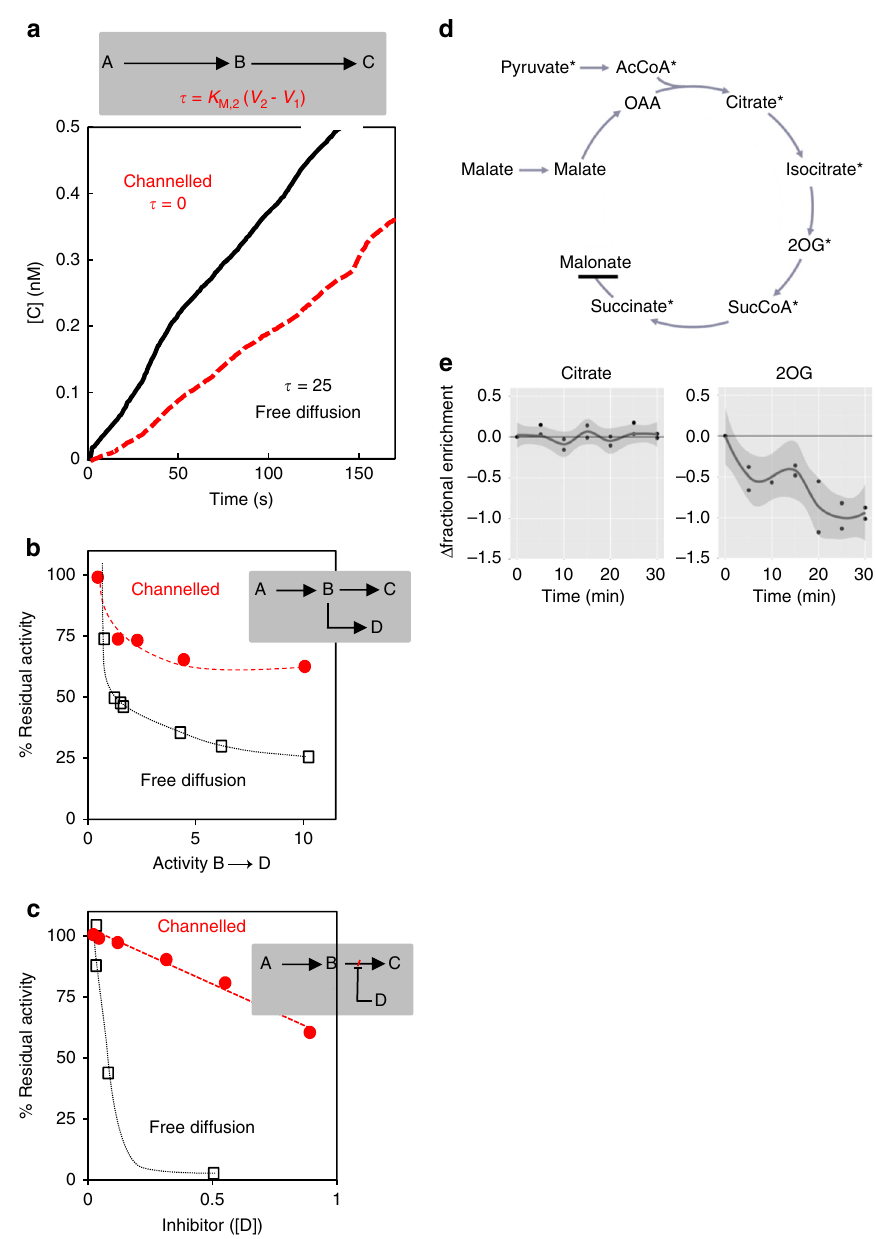
Fig. 1 Methods of identifying substrate channelling. a Reaction scheme and depiction of transient time ( t ) analysis based on data from a channelled bifunctional thymidylate synthase-dihydrofolate reductase (TS-DHFR) and a freely diffusing monofunctional TS and DHFR (data from ref. 64 ). b Comparison of residual activity of a channelled or freely diffusing enzyme pair in the presence of a competing enzyme, for example, the malate dehydrogenase and citrate synthase couple in the presence or absence of aspartate aminotransferase, which competes for the metabolic intermediate oxaloacetate (data from ref. 82 ). c Comparison of residual activity of a channelled or freely diffusing enzyme pair in the presence of an inhibitor of the second enzyme, for example, the inhibition of the TS-DHFR cascade by the inhibition of DHFR by pyruvate (data from ref. 64 ). d Schematic representation of the isotope dilution experiment to assess the channelling of citrate and 2OG. 13 C-labelled pyruvate was fed to isolated potato mitochondria and the label accumulation in succinate was monitored. The TCA cycle was inhibited by malonate to avoid the complication of multiple turns of the cycle. Non-labelled citrate and 2OG were added into the medium following the fractional enrichment in succinate reaching steady state. Asterisks show the expected fate of labelled carbon following the metabolism of pyruvate under the experimental conditions. e The result of isotope dilution experiments for citrate and 2OG. The time course plots show the fractional 13 C enrichment in succinate following the addition of unlabelled citrate or 2OG at 0 min. The line is the smoothed conditional mean with the shadow representing a 95% con fi dence interval. The metabolite is considered not to be channelled when the con fi dence interval line falls below 0. Panels a – c has been adapted with permission from ref. 10 . Panels d , e has been reproduced with permission from ref.